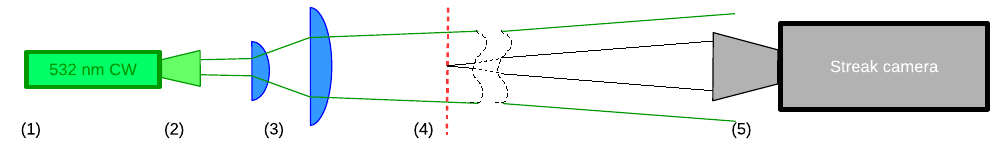
Figure 3. (Color online) optical configuration of the streak camera and CW laser illumination system. (1) CW 532 nm laser head, (2) beam expander X10, (3) two lenses combination, (4) exploding wire and (5) streak camera and